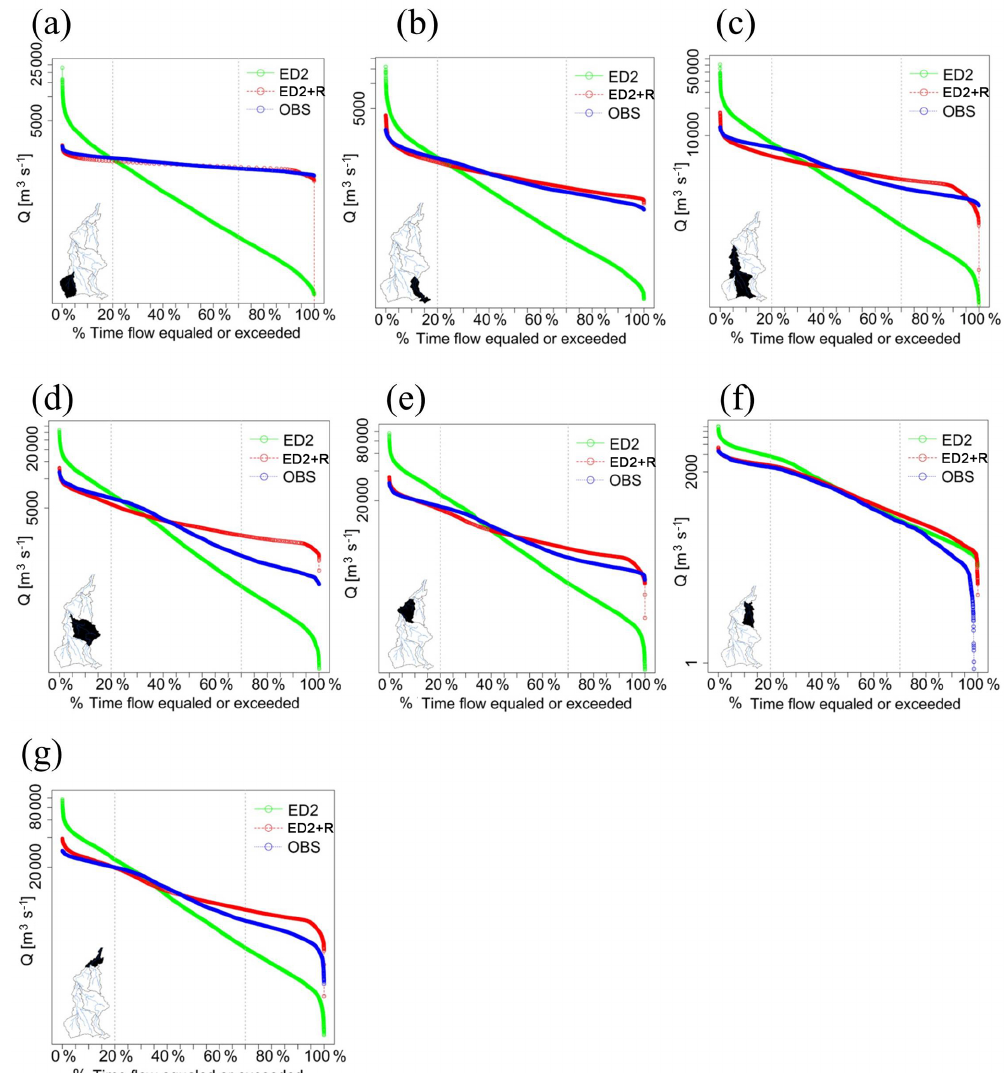
Figure 9. Flow duration curves (percentage of time that flow – m 3 s − 1 – is likely to equal or exceed determined thresholds) of observed values (blue), ED2 outputs (green), and ED2 + R (red) at the outlet of the seven sub-basins. (a) Upper Juruena (UJ); (b) Upper Teles Pires (UTP); (c) Lower Juruena (LJ); (d) Lower Teles Pires (LTP); (e) Upper Tapajós (UT); (f) Jamanxim (JA); and (g) Lower Tapajós